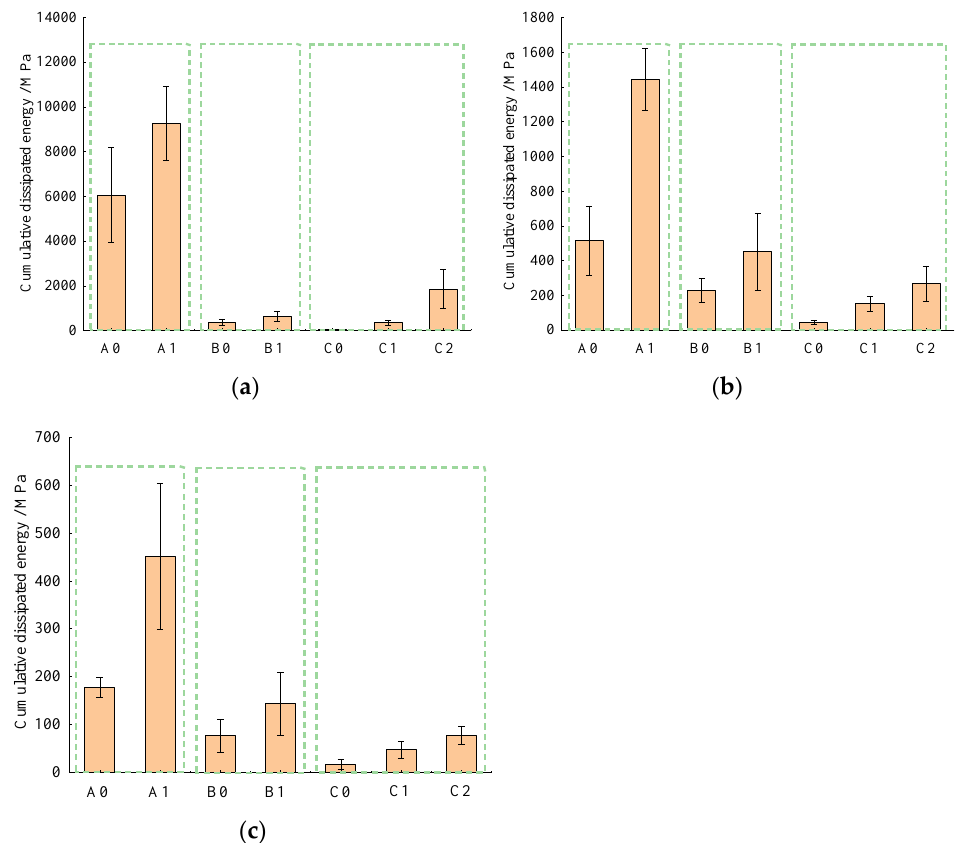
Figure 8. Cumulative dissipated energy: ( a ) 450 με , ( b ) 650 με and ( c ) 850 με .